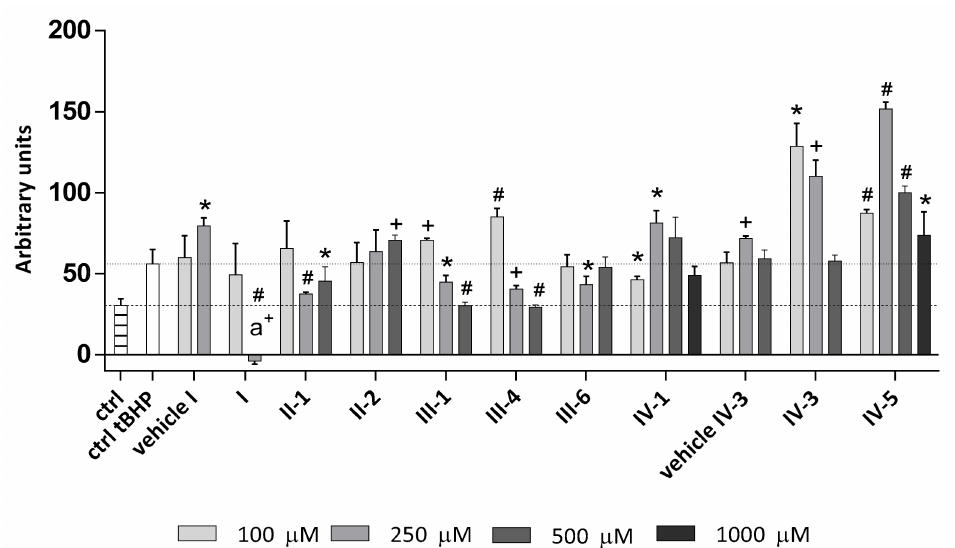
Figure 5. Intracellular ROS levels upon 24-h treatment with DHPs in mild oxidative stress conditions (1-h treatment with 50 µ M t-BHP). Results are expressed in arbitrary units, adjusting the difference in fluorescence measurement after 1-h treatment with tBHP and zero-point (before addition of tBHP) with the cell number. Values are given as mean ± standard deviation ( n = 3). Statistically significant differences are shown as follows: * p < 0.05; + p < 0.005; # p < 0.0005 (in comparison to the treatment control (ctrl tBHP; dotted line)); and a + p < 0.005 (in comparison to the non-treated control (ctrl; dashed